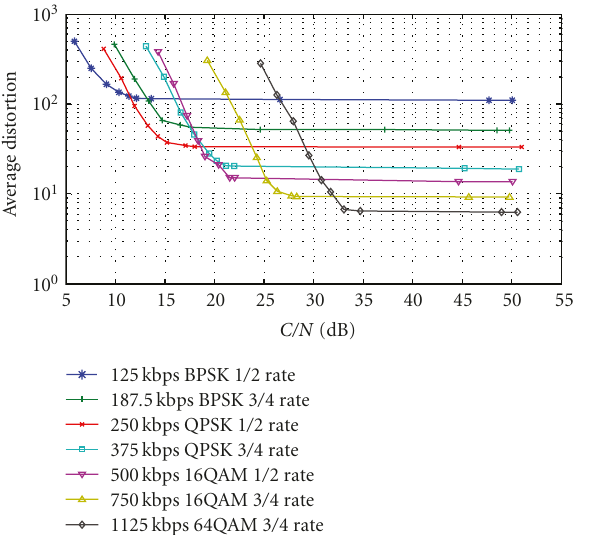
Figure 14: Optimum distortion-based link adaptation, table , GOP number 21, Set